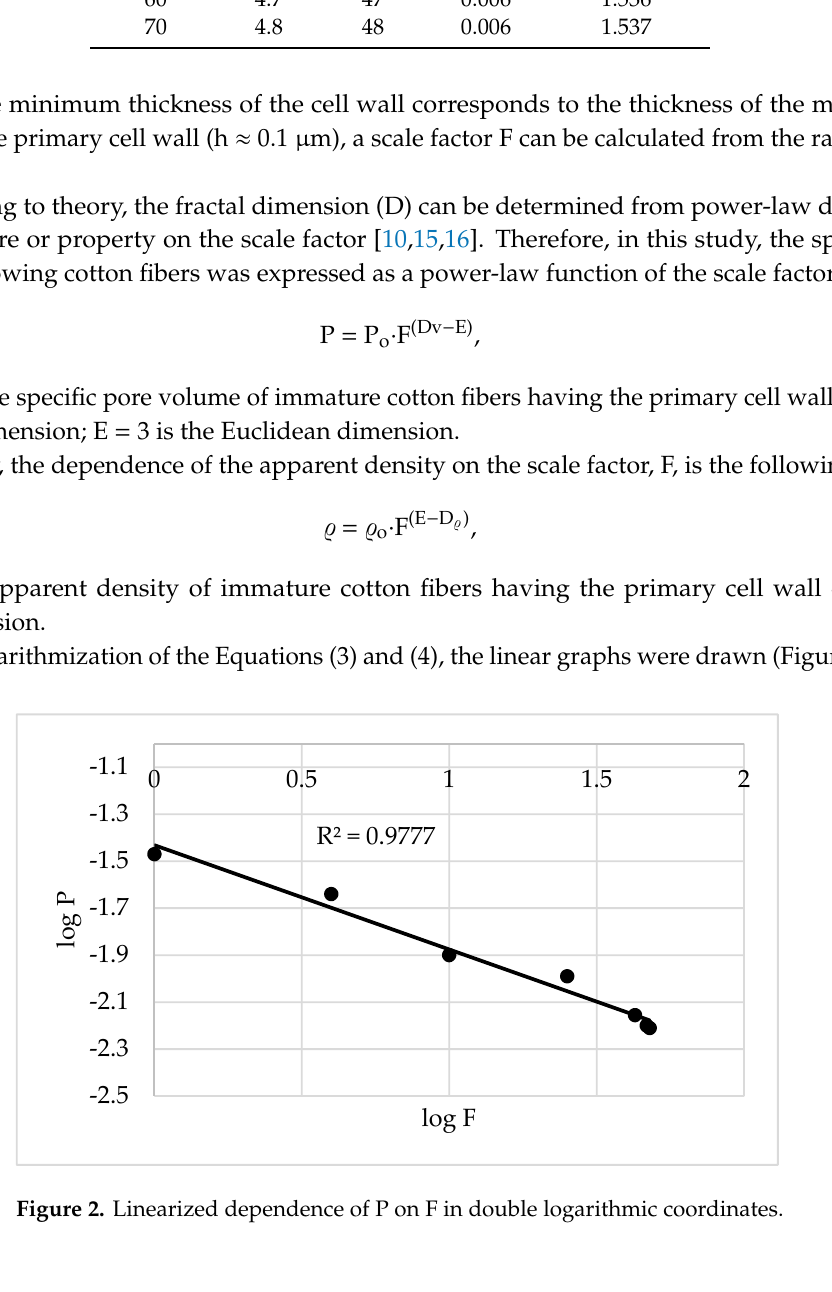
Figure 1. Dependence of cell wall thickness on days post anthesis (DPA) of cotton fibers . Table 1. Characteristics of cotton fibers of various age.